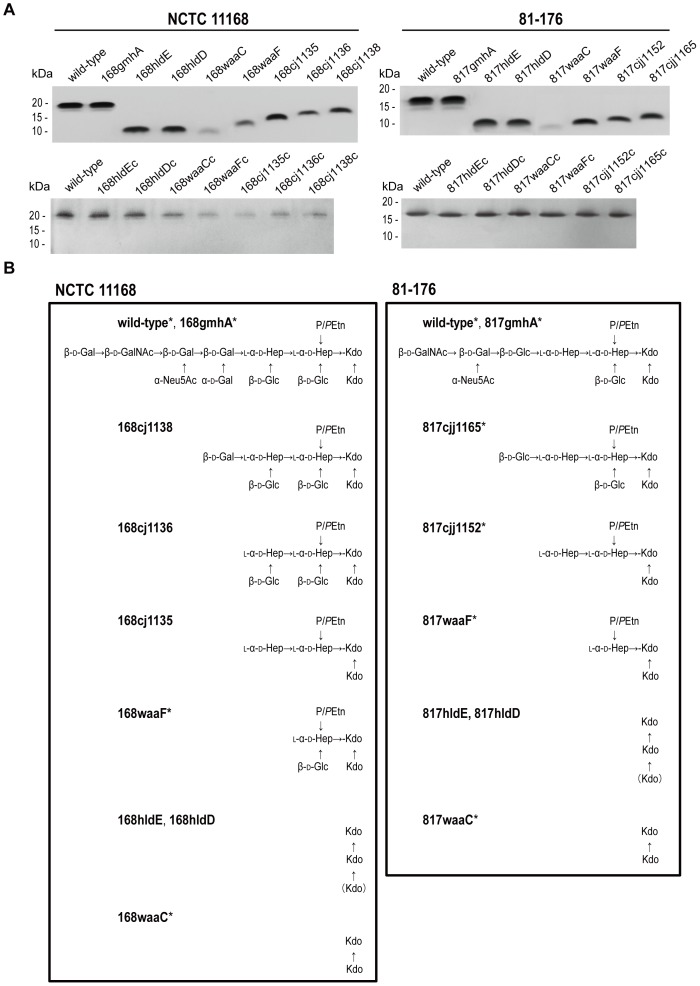
LOS profiles and LOS OS structures of the C. jejuni wild-type strains (NCTC 11168 and 81-176) and mutants.(A) LOS samples were analyzed by tricine-SDS-PAGE using 16% tricine gels and visualized by silver staining. The positions of the protein size markers are indicated on the left of each panel. (B) The LOS structures of 168hldE, 168hldD, 168cj1135, 168cj1136, 168cj1138, 817hldE, and 817hldD were analyzed by MALDI-TOF MS and GC-MS in this study. The wild-type strains and other mutants with asterisks have structures similar to those determined in previous studies [24]–[26], [52]–[54]. Abbreviations, refer to the legend of Fig. 1.